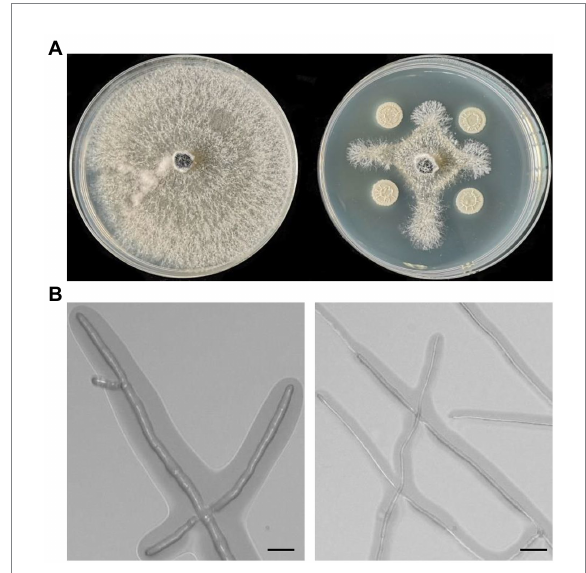
FIGURE 1 Strain Pl7 inhibition of B. dothidea mycelial development. (A) B. dothidea colony morphology at 6 dpi on PDA medium. (B) B. dothidea hyphal morphology 2 days after conflict with strain Pl7. B. dothidea CK is on the left. Scale Bar = 10 μ